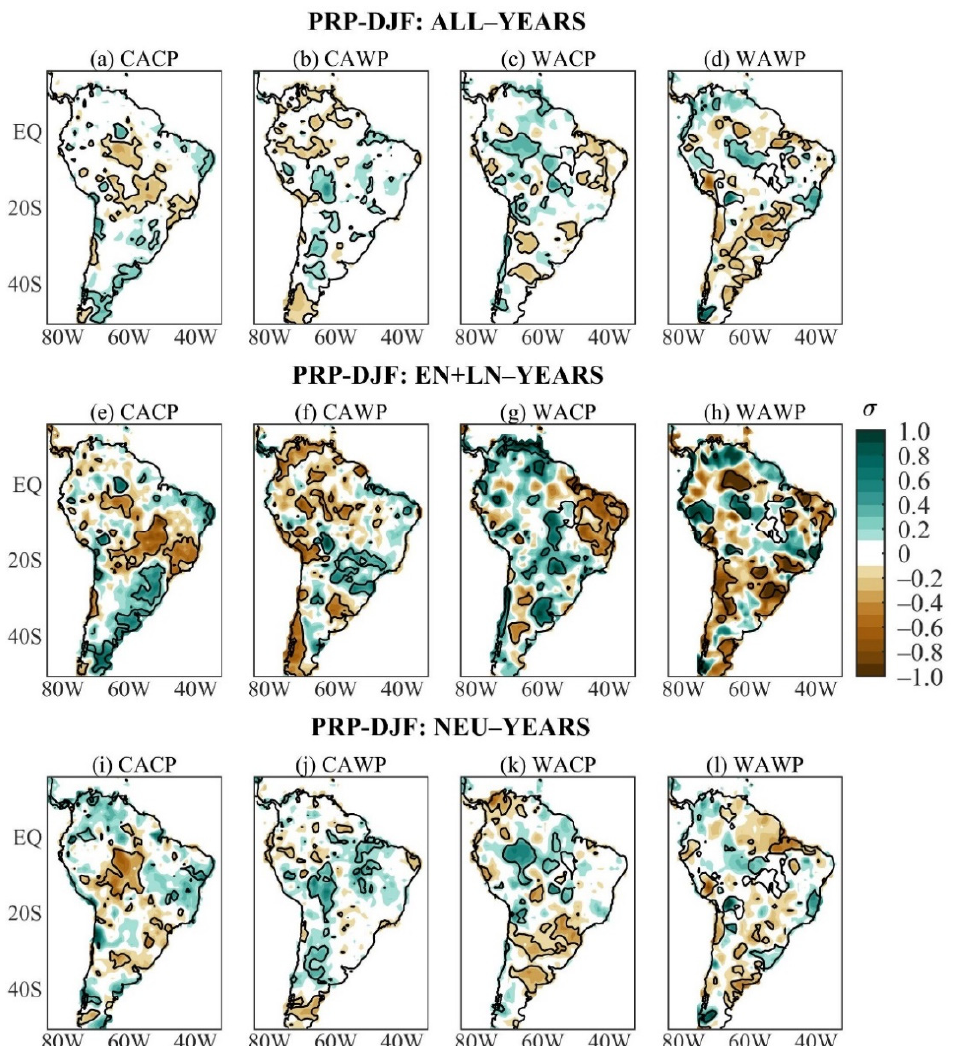
Figure 5. Austral summer PRP anomaly composites of ALL-years during the: ( a ) CACP, ( b ) CAWP, ( c ) WACP, and ( d ) WAWP mean states; of EN + LN-years during the: ( e ) CACP, ( f ) CAWP, ( g ) WACP, and ( h ) WAWP mean states; of NEU-years during the: ( i ) CACP, ( j ) CAWP, ( k ) WACP, and ( l ) WAWP mean states. Continuous contours encompass the significant anomalies at a 90% confidence level using the Student’s t -test. The symbol σ above the colour bar means standard deviation.